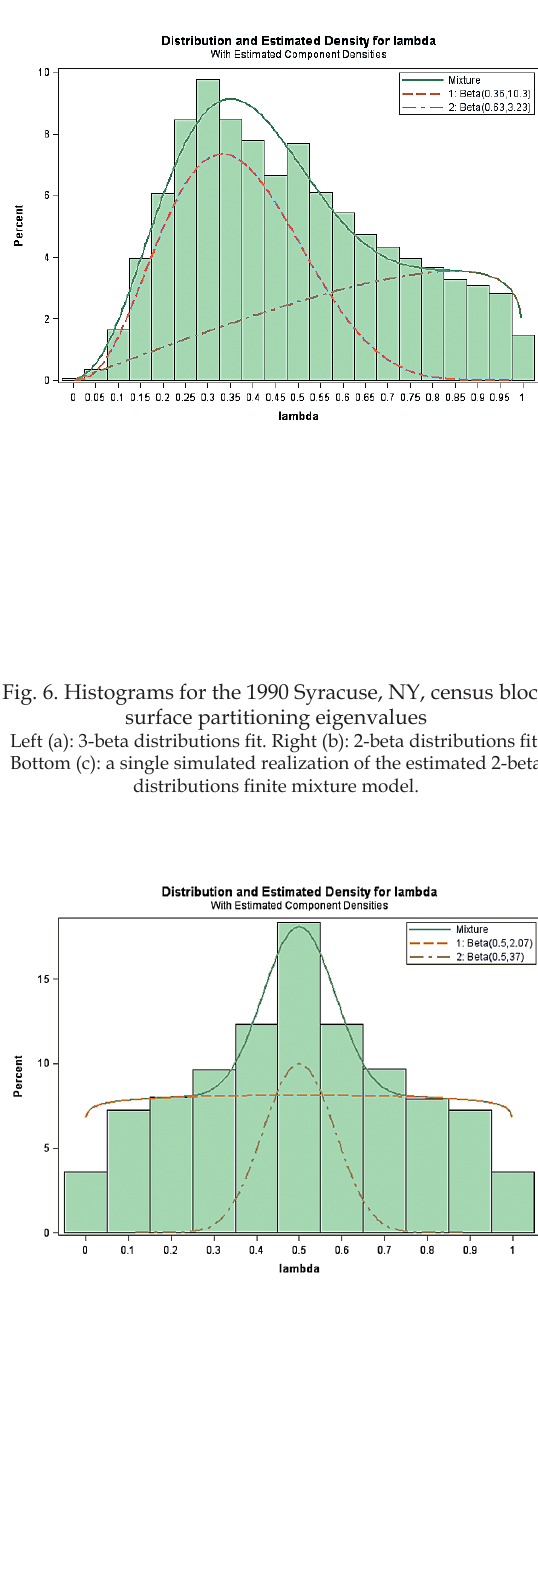
Fig. 7. Specimen cases for a regular square tessellation Left (a): n = 900. Right (b): n = 1,600. Bottom (c): n =